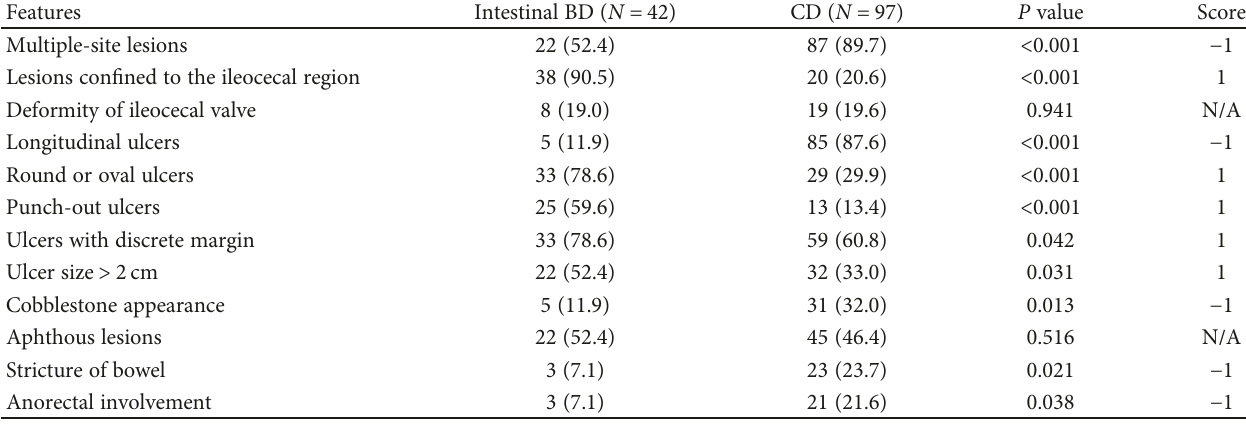
Table 2: Endoscopic features of intestinal BD and CD.